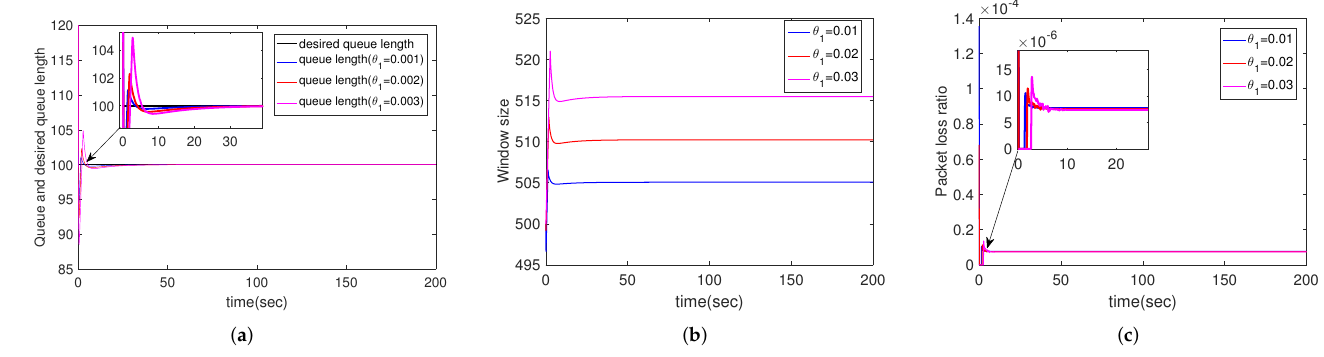
Figure 5. Simulation results of multiple routers using CCAIB for different uplink packet loss ratios. Columns from left to right show the performance of CCAIB in ( a ) queue length stability, ( b ) window size and ( c ) packet loss ratio in the